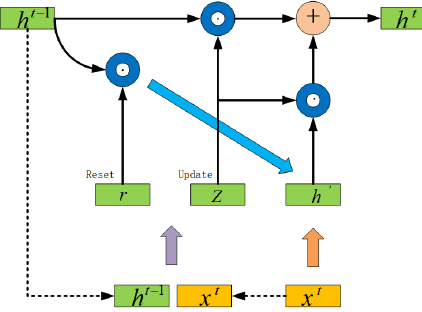
Figure 3. GRU internal structure